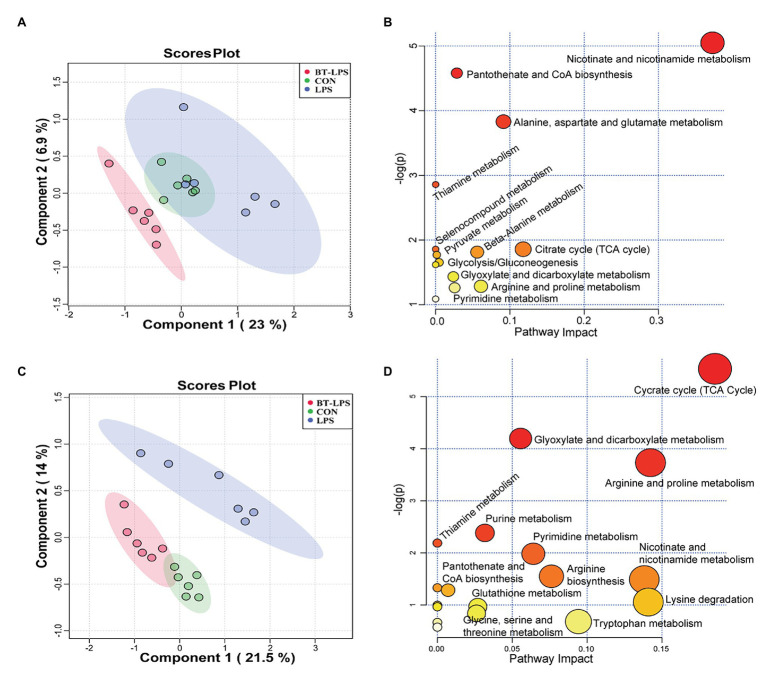
Butyrate supplementation altered the energy metabolism profile in the gut–liver axis. (A,C) Partial least squares–discriminant analysis plots, in the colon and liver, show that hydrophilic metabolome in the gut–liver was affected by LPS challenge and butyrate administration. (B,D) In the colon and liver, overview of pathway analysis of significant metabolites. Each circle displays one matched pathway, with the color and size of each circle based on the p-value and the pathway impact value, respectively.